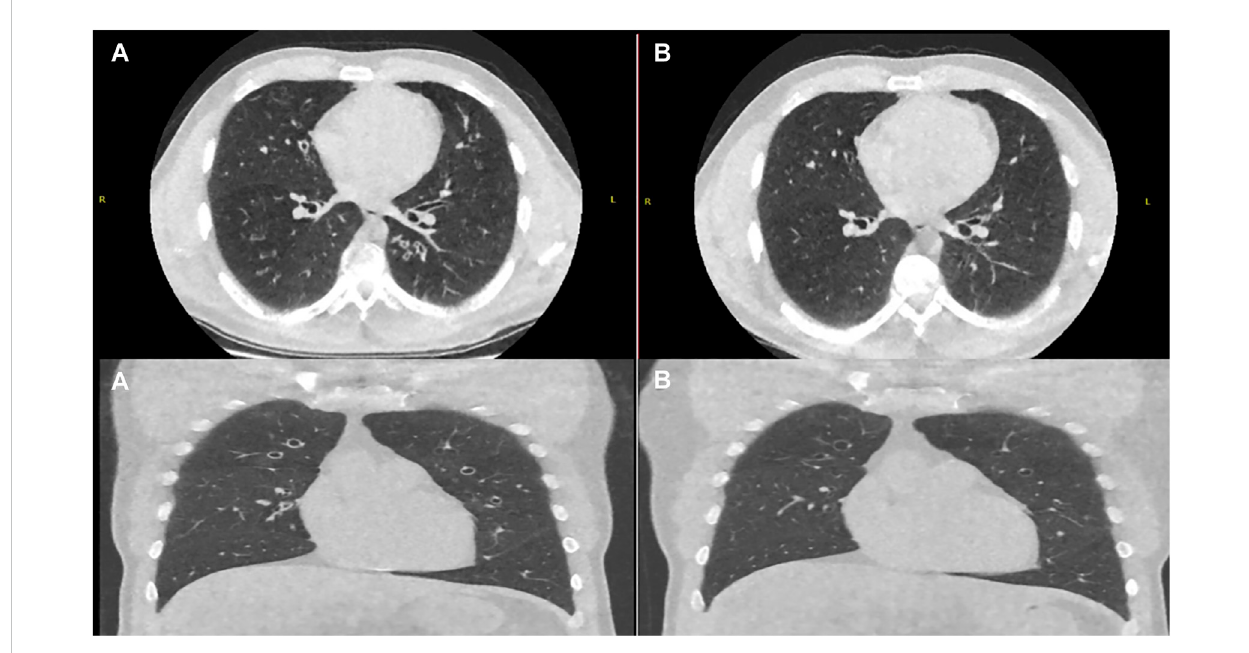
FIGURE 4 Axial and Coronal Ultra-Low Dose CT Thorax pretreatment (A) and post modi fi ed dose regimen (B) showing reduction in the degree of bronchial wall thickening and mucoid